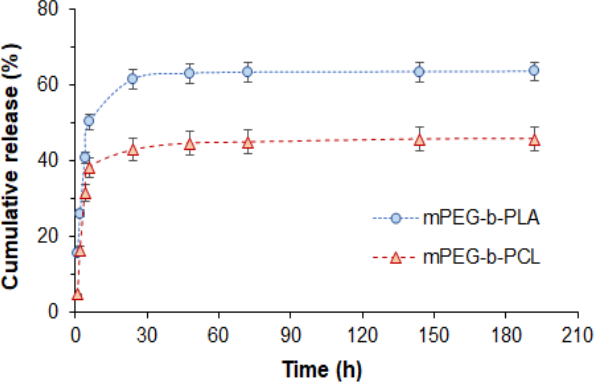
Figure 10. Storage stability of DOD/mPEG- b -PLA ( a , b ) and DOD/mPEG- b -PCL ( c , d ) nanomedicines in water ( a , c ) and 0.01 M PBS at a pH of 7.4 ( b , d ) at different temperatures. For the characteristics of the delivery system, see Table 3 (initial DOD amount, 400 µ g/mg polymer).